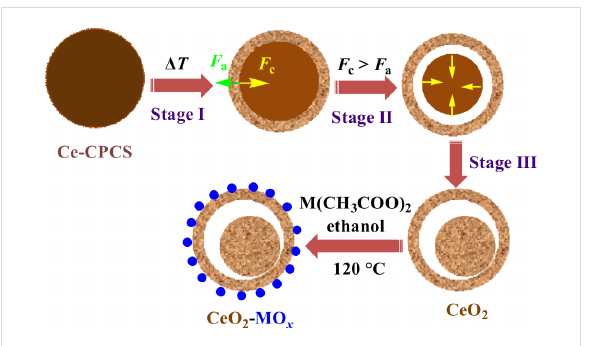
Figure 1: Schematic illustration of the formation of CeO 2 –MO x com- posite yolk–shell nanospheres.